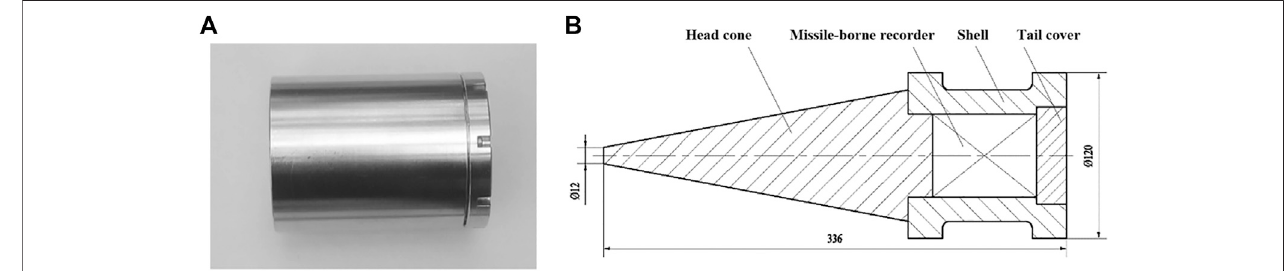
FIGURE 1 | (A) The missile-borne recorder and (B) structural diagram of the experimental piece.